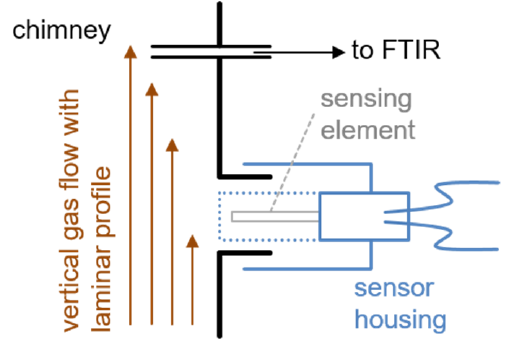
Figure 3. Scheme of the sensor mounting position in real exhaust measurements on the fringe of a vertical chimney. The tip of the sensing element is slightly recessed and not directly exposed to the gas flow.